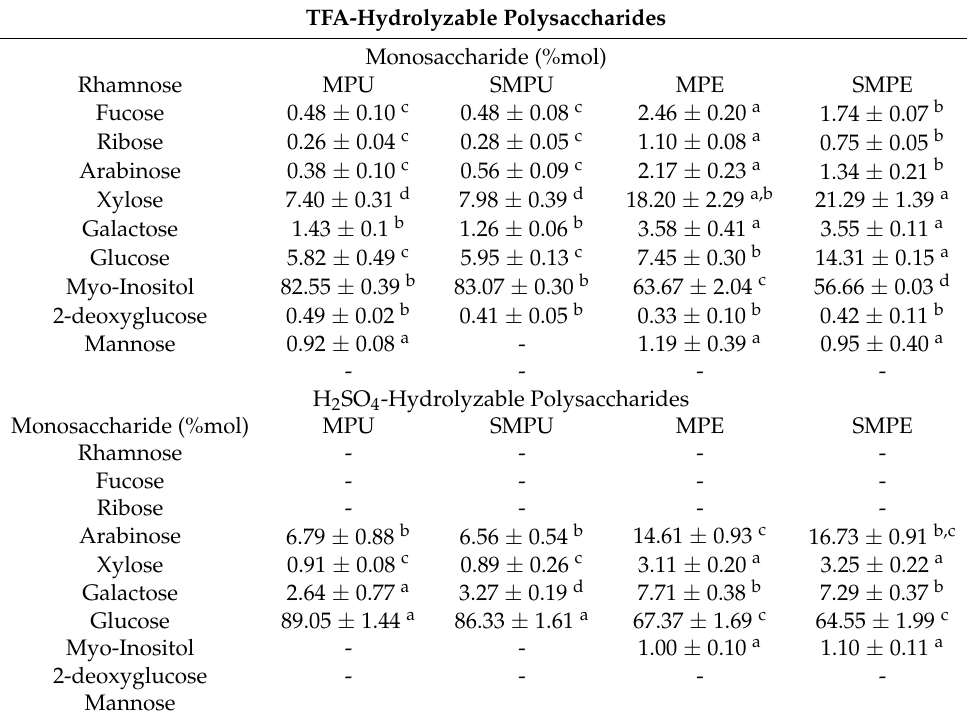
Table 2. Monosaccharide composition of umbu by-products. TFA-Hydrolyzable